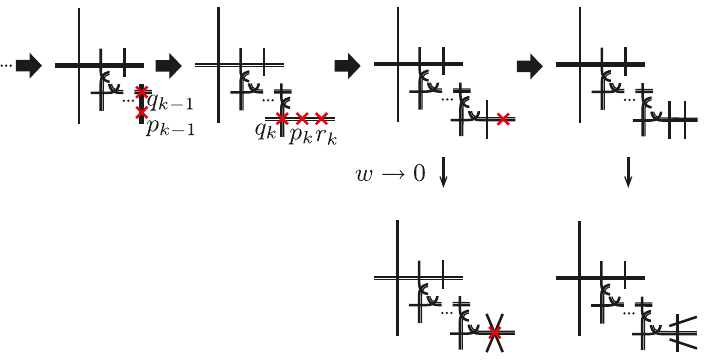
Figure 7 . Singularities and exceptional curves in the split I ∗